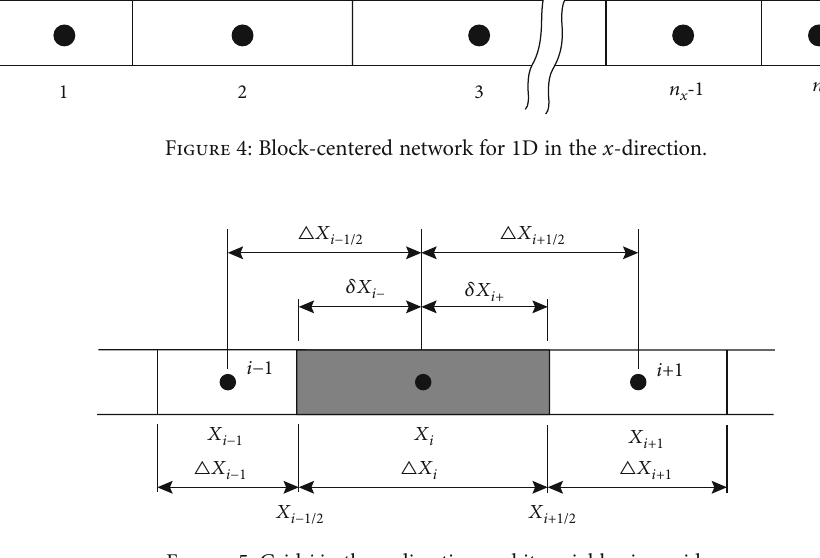
Figure 5: Grid i in the x -direction and its neighboring